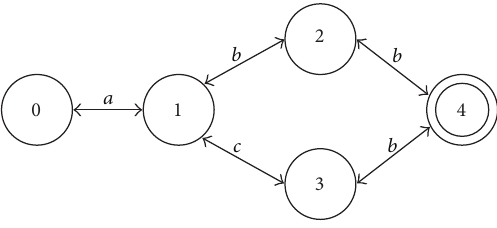
Figure 2: A deterministic finite state automaton (DFA).